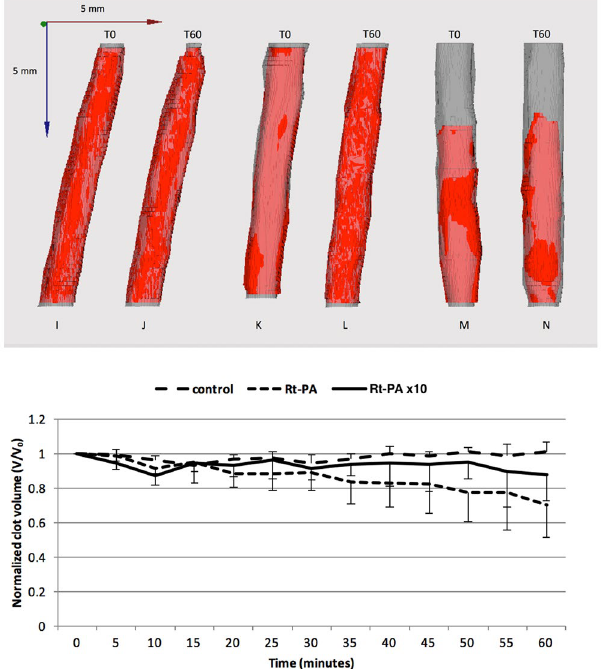
Figure 5. In vitro Rt-PA delivery in the full occlusion model. Blood clots were treated with a range of Rt-PA alone in a range of concentrations (0, 3, 30 µ g/ml). The blood clot volume was assessed every 5 min for 60 min using high frequency ultrasound imaging. 3D reconstructions of clots were made at T0 and T60 (top). I-J: Control; K-L: Rt-PA; M-N: Rt-PAx10. Data expressed as mean ± SEM were calculated from four independent experiments